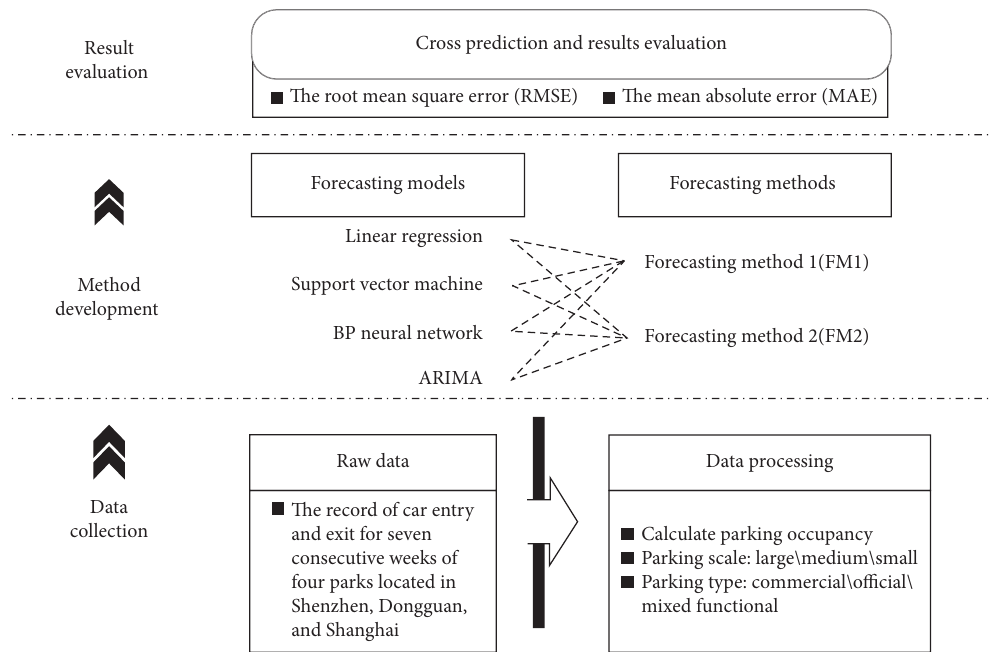
Figure 1: Research framework for the comparison of parking occupancy prediction